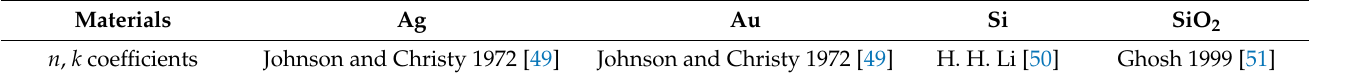
Table 2. Values of the refractive index and extinction coefficient used in the